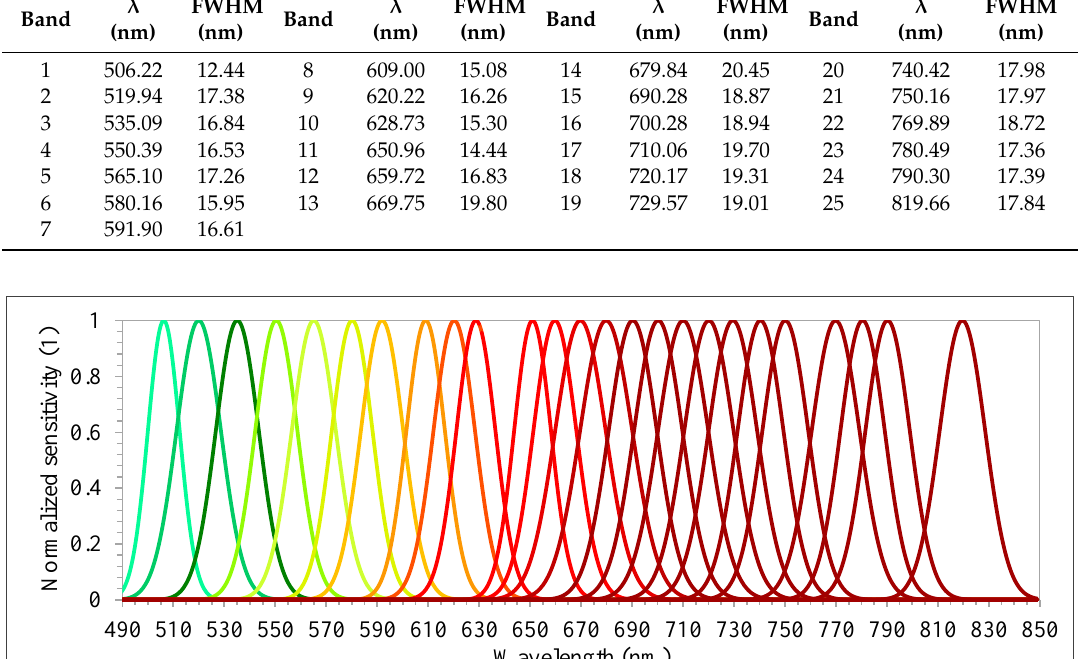
Figure 4. Normalized sensitivities of each spectral band set in the FPI camera. Responses were calculated from the central wavelength and FWHM.